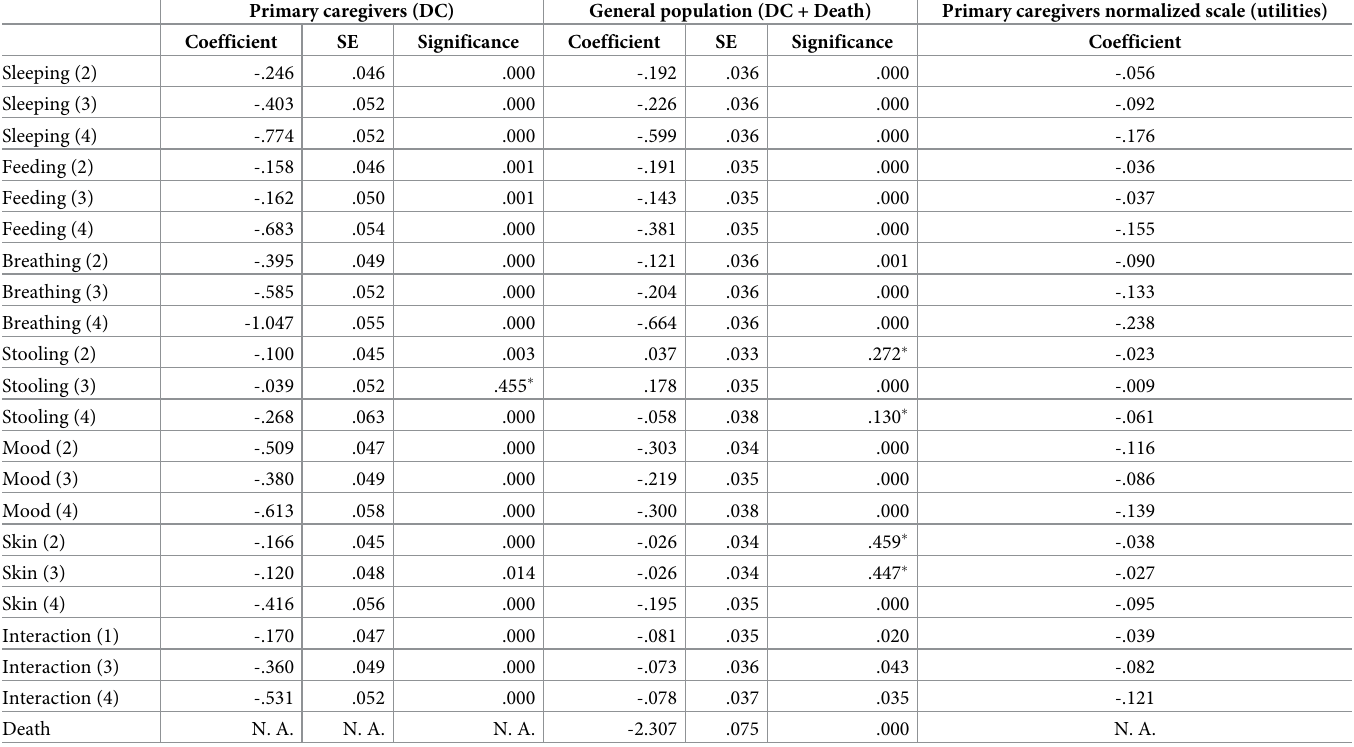
Table 2. Parameter estimates for the levels of the 7 IQI health items separately for the primary caregivers, the general population, and the normalized primary care- givers’